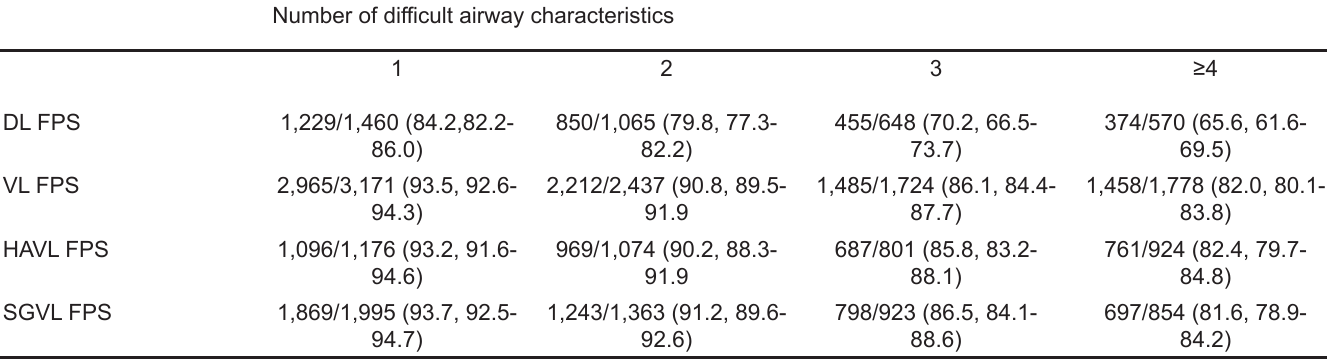
Data is reported as ratios (%, 95% confidence interval).